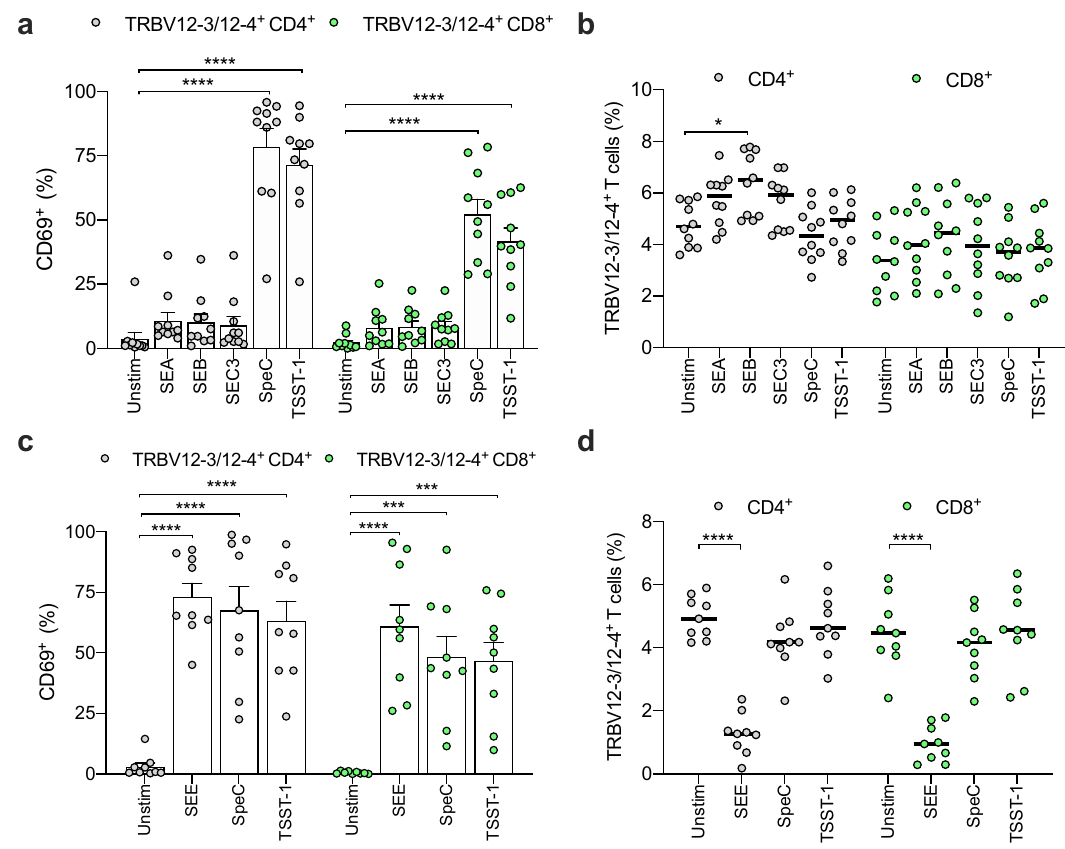
Fig. 1 SpeC and TSST-1 activate TRBV12-3/12-4 + CD4 + and CD8 + T cells. a Frequency of CD69 + cells among TRBV12-3/12-4 + CD4 + (gray fi lled circles) or CD8 + T cells (green fi lled circles) from human PBMCs cultured in medium alone (unstim) or stimulated for 24 h with SEA, SEB, SEC3, SpeC, or TSST-1. Each dot represents one donor. Data are shown as mean ± SEM. **** p < 0.0001. One-way ANOVA with Tukey ’ s post-hoc test. b Frequency of TRBV12-3/12-4 + cells among CD4 + (gray fi lled circles) or CD8 + T cells (green fi lled circles) from human PBMCs cultured in medium alone (unstim) or stimulated for 24 h with SEA, SEB, SEC3, SpeC, or TSST-1. Each dot represents one donor. Horizontal bars indicate median values. * p < 0.05. One-way ANOVA using transformed data with Tukey ’ s post-hoc test. c Frequency of CD69 + cells among TRBV12-3/12-4 + CD4 + (gray fi lled circles) or CD8 + T cells (green fi lled circles) from human PBMCs cultured in medium alone (unstim) or stimulated for 24 h with SEE, SpeC, or TSST-1. Each dot represents one donor. Data are shown as mean ± SEM. *** p < 0.001, **** p < 0.0001. One-way ANOVA with Tukey ’ s post-hoc test. d Frequency of TRBV12-3/12-4 + cells among CD4 + (gray fi lled circles) or CD8 + T cells (green fi lled circles) from human PBMCs cultured in medium alone (unstim) or stimulated for 24 h with SEE, SpeC, or TSST-1. Each dot represents one donor. Horizontal bars indicate median values. **** p < 0.0001. One-way ANOVA using transformed data with Tukey ’ s post-hoc